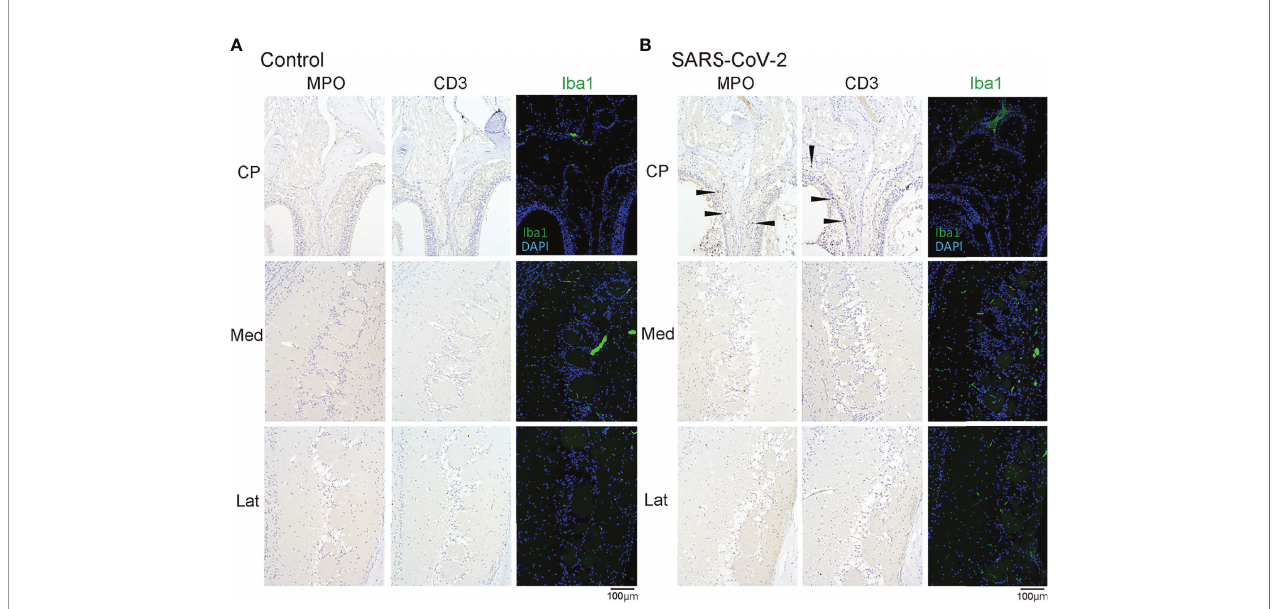
FIGURE 5 | MPO/CD3/Iba1 positive cells in the olfactory bulb area. Representative immunohistological images of MPO and CD3 in the olfactory bulb area ( A : control hamster, B : SARS-CoV-2 hamster). Some MPO + cells and CD3 + cells are observed in the olfactory mucosa around the cribriform plate (arrow heads). CP, cribriform plate area; Iba1, ionized calcium-binding adaptor molecule 1; Lat, lateral area; Med, medial area; SARS-CoV-2, severe acute respiratory syndrome coronavirus